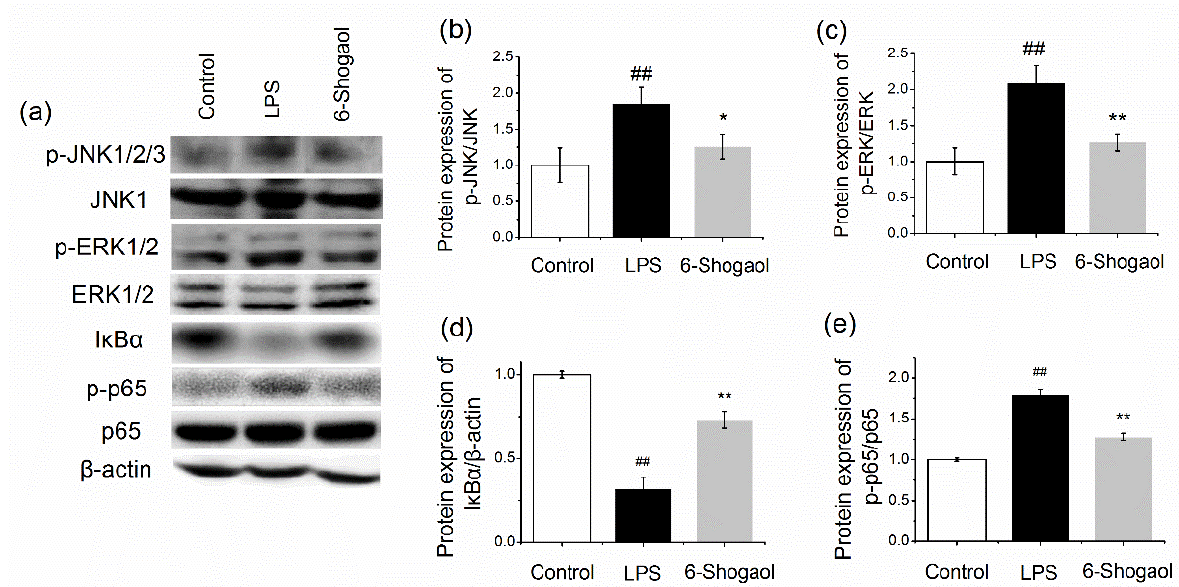
Figure 2. 6-Shogaol inhibited hepatic inflammation through MAPK/NF κ B pathway. ICR mice received daily oral administrations of 6-shogaol (20 mg/kg) for 7 consecutive days. The control and LPS groups were administered with the vehicle. On day 8, mice in LPS and 6-shogaol groups received an i.p. injection of LPS (10 mg/kg). After 24 h, the mice were sacrificed: ( a ) the blots; ( b ) hepatic protein expression of p-JNK/JNK; ( c ) hepatic protein expression of p-ERK/ERK; ( d ) hepatic protein expression of I κ B α ; ( e ) hepatic protein expression of p-p65/p65. Data are presented as mean ± SEM ( n = 3). ## p < 0.01 versus control group; * p < 0.05, ** p < 0.01 versus LPS group.